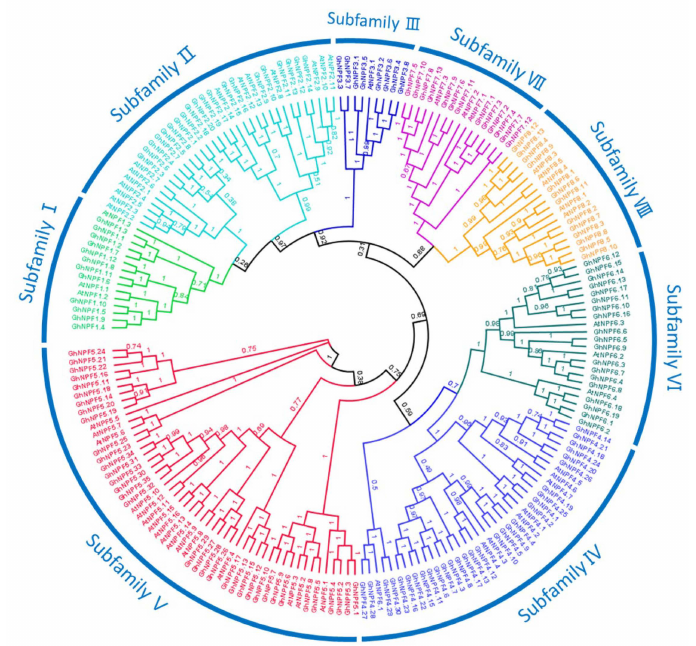
Figure 1. Phylogenetic tree and subgroup classification of NPF proteins in A. thaliana and Gossypium hirsutum . The numbers at the nodes of the phylogenetic tree indicate the bootstrap values expressing branching probability per 1000 replicates; the bootstrap values of the confidence levels are shown as percentages.